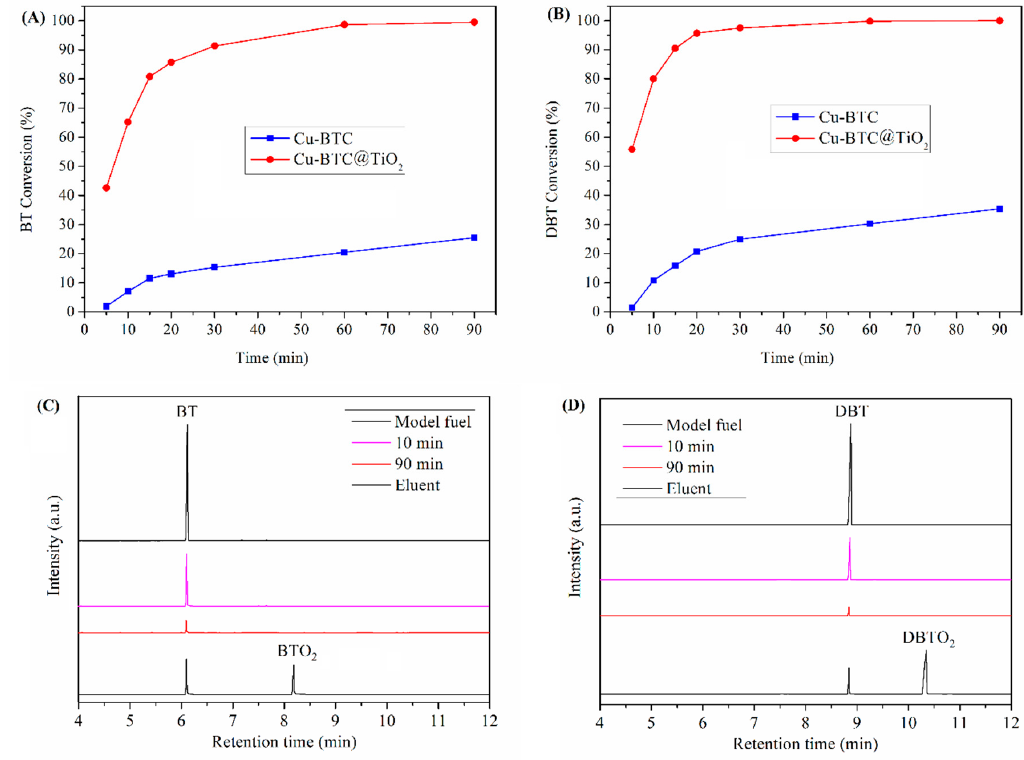
Figure 8. Conversion of BT ( A ) and DBT ( B ) for Cu-BTC and Cu-BTC@TiO 2 . Gas chromatography of the initial model fuel contained BT ( C ) and DBT ( D ), desulfurized fuel samples with adsorption times of 10 and 90 min, and the eluent of the spent Cu-BTC@TiO 2 (sulfur concentration 1000 ppm, sample amount 100 mg, air flow 60 L/h, reaction temperature 80 °C).